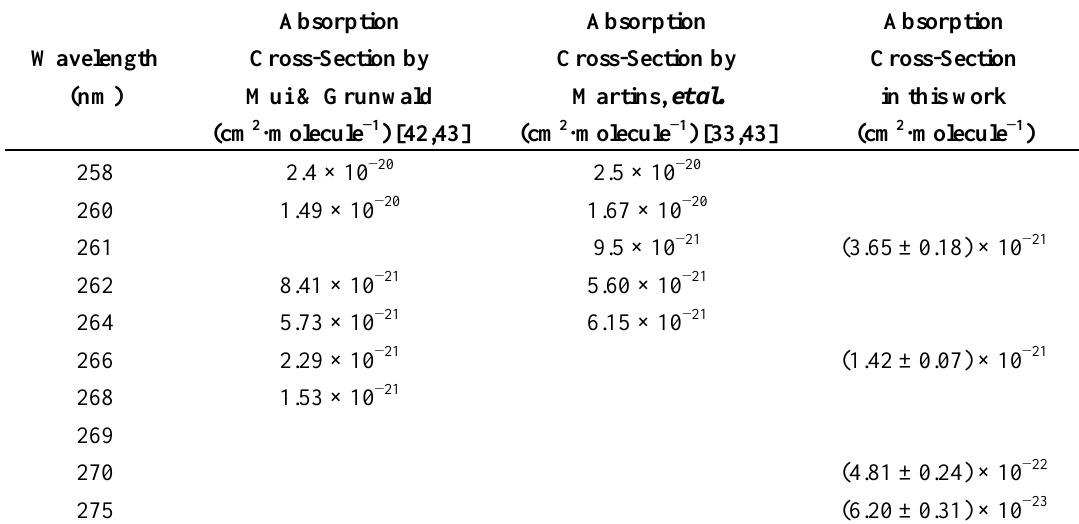
Table 1. Absorption cross-sections of isoprene around 266 nm: A comparison of the data from this work with those reported in the